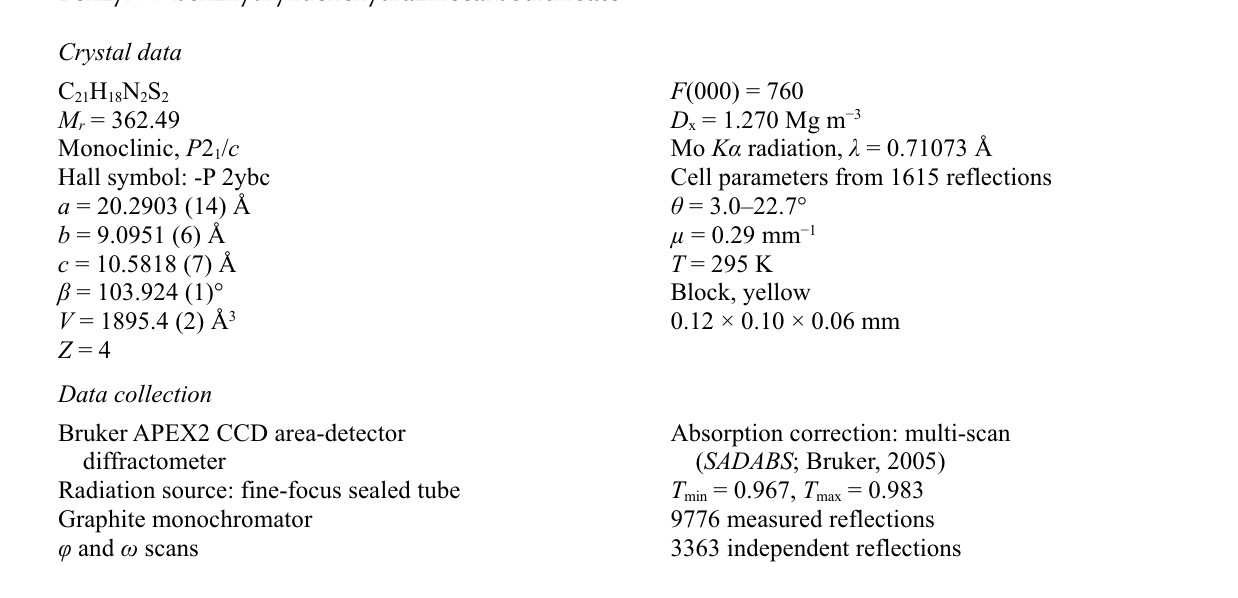
The molecular structure of (I), with displacement ellipsoids drawn at the 30% probability